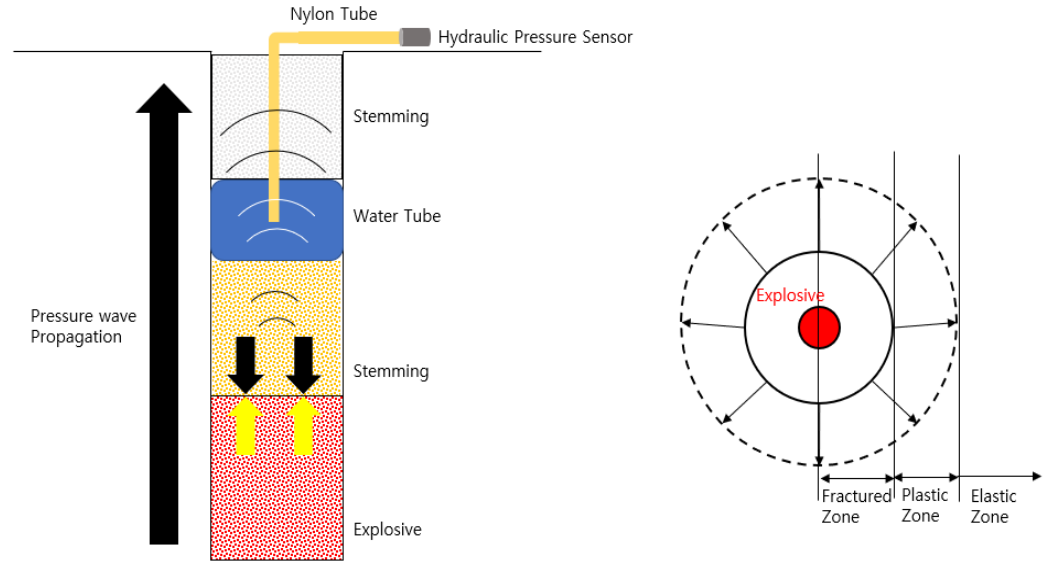
Figure 18. Schematic of the measured pressure wave in the blast hole.